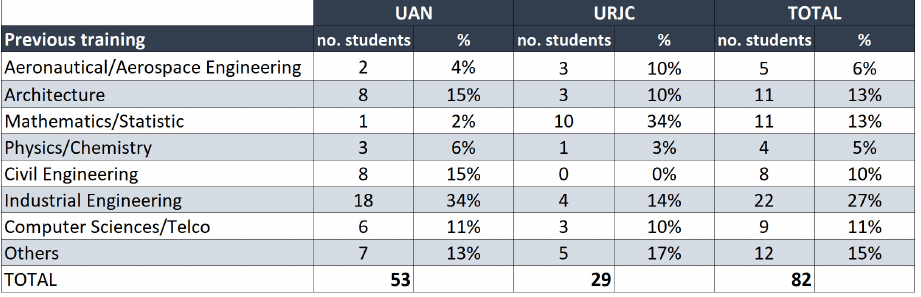
Figure 5. Distribution of students that completed the questionnaire according to their previous undergraduate studies. Data are given by university (UAN, URJC) and total, then the number of students (no.students) and their percentage (%) of the total in their